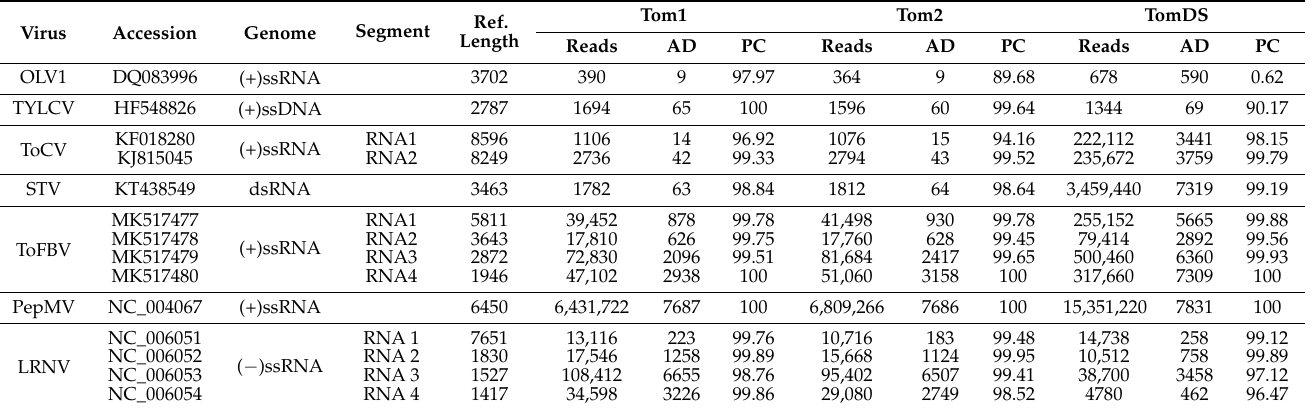
Table 3. Summary of mapping of reads against identified viral